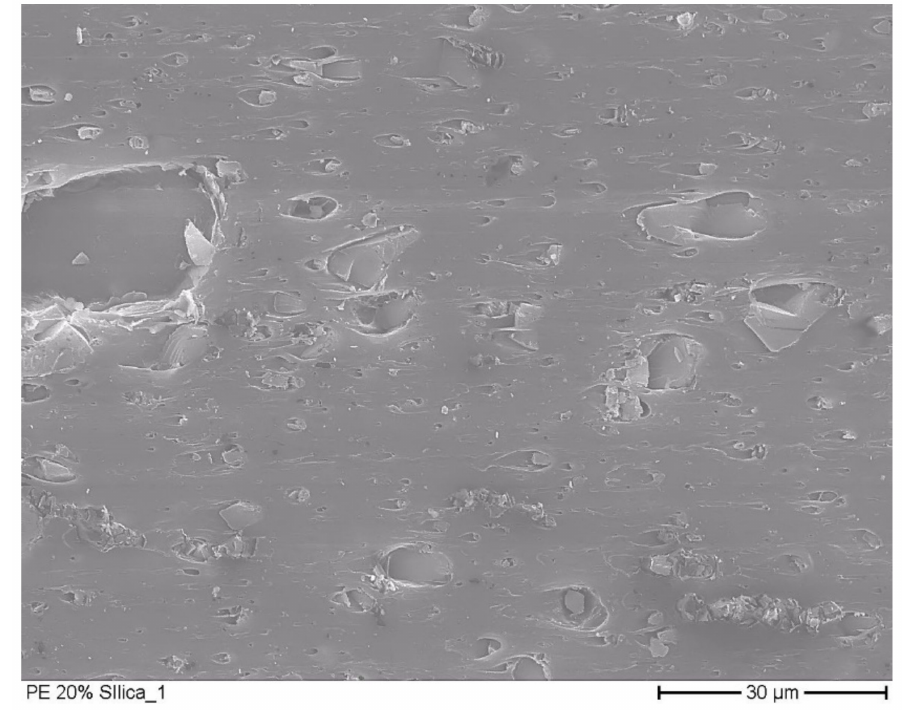
Figure 1. Electron microscopic picture of film with 0.2 g silica gel / g film. Table 1. Thicknesses of the films used for the sorption experiments, tensile tests, the determination of (e ff ective) water vapor permeability coe ffi cients, gas permeability.